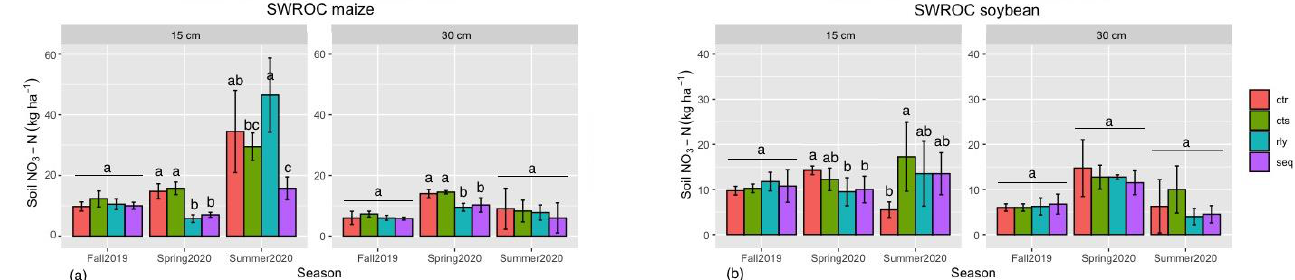
Figure 3. Effects of N – fertilized winter camelina double cropped with maize and soybean on soil available N at two soil layers: ( a ) 0 – 15 cm and ( b ) 15 – 30 cm with standard deviation. Southwest Research and Outreach Center (SWROC), 2019 – 2020. ctr = control relay, cts = control sequential, rly = relay cropping, and seq = sequential cropping. In a given season and depth within a location, bars followed by different letters are significantly different at p ≤ 0.05.